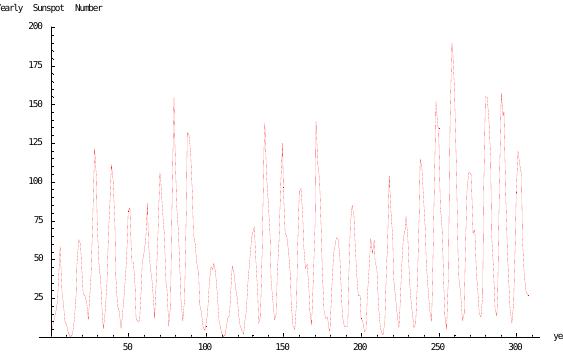
Fig. 1. Historical yearly sunspot number time series 1700–2005. Those original numbers, derived from numerous visual observa- tions, show not only the 11-year pulsation but also its irregular vari- ations in amplitude and periodicity.